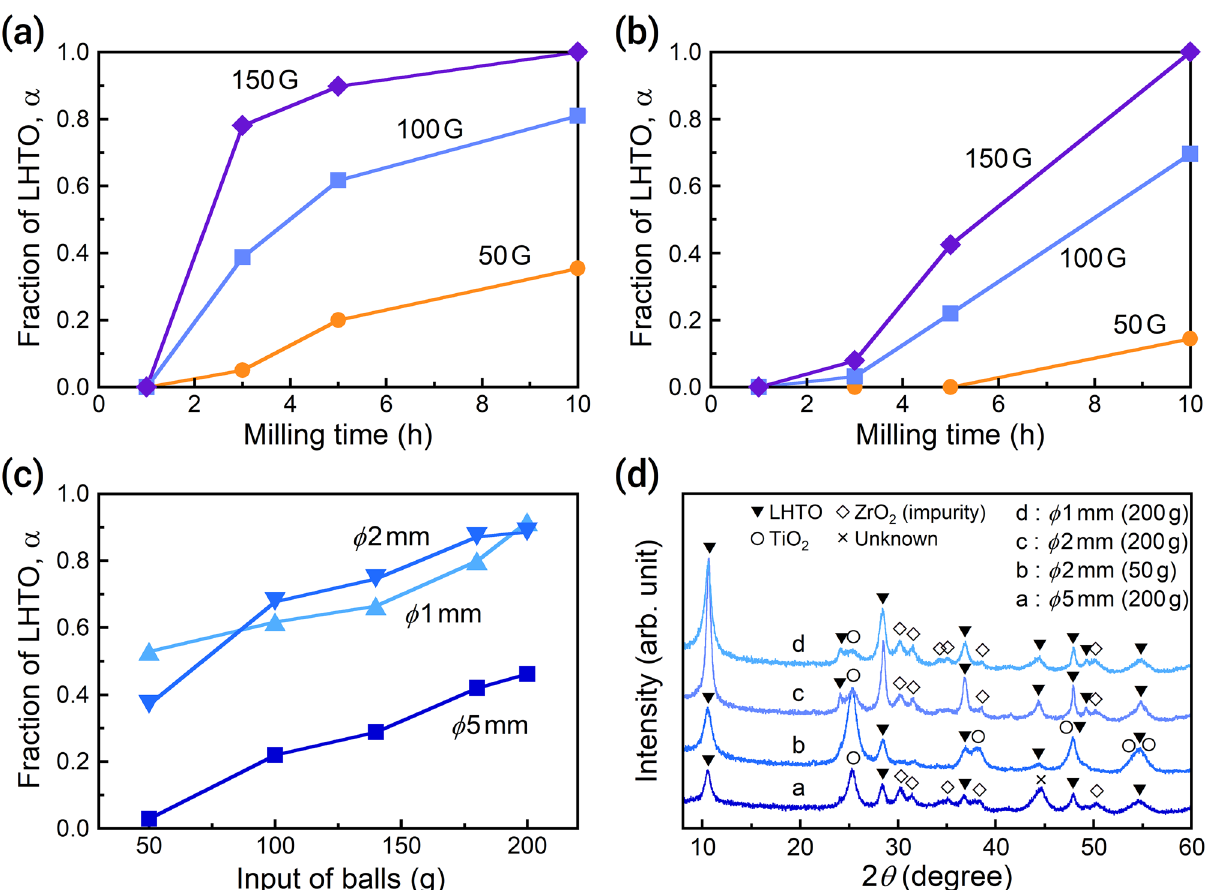
Figure 1. Formation of LHTO through the wet mechanochemical reaction. Formation fraction of LHTO after wet planetary ball milling at 50–150 G for 1–10 h with 100 g of balls at ( a ) ball input and size on the reaction at 100 G for 5 h. ( d ) XRD patterns of typical products obtained at 100 G for 5 h using balls of different sizes and